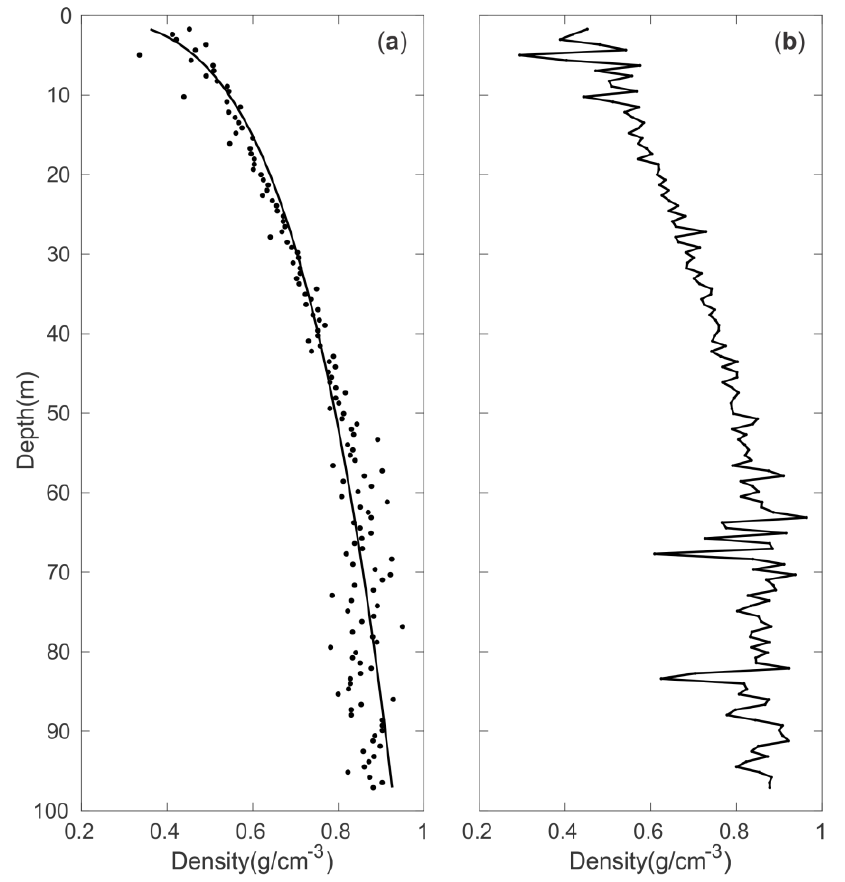
Figure 1. Panel ( a ) shows the density ρ ( z ) as dots and the model expressed by equation (2), as a solid curve. Panel ( b ) shows the decimated density series as a solid